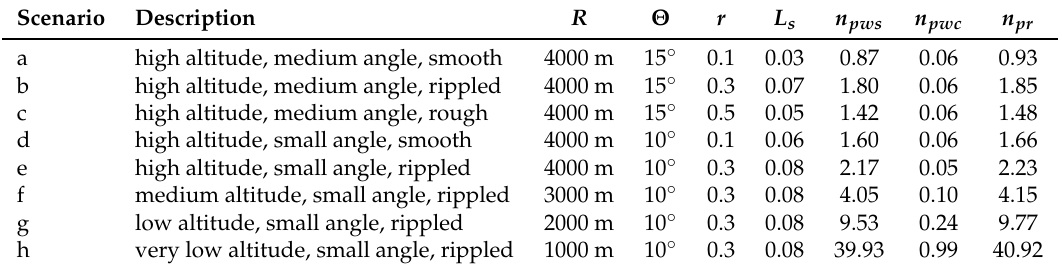
Table 2, n pr denotes the expected number of photons from reflection near the air–water interface as the sum of photons backscattered from the water surface ( n pws ) and the 2 cm water layer ( n pwc ). Table 2. Estimated photon count for representative data acquisition scenarios and surface